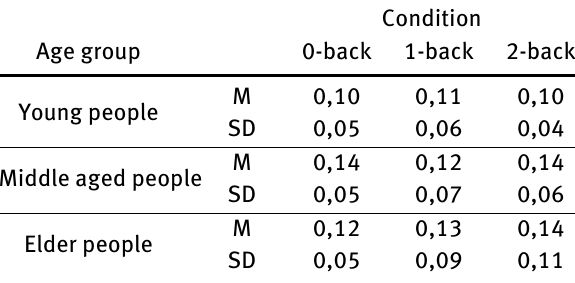
Table 2: The standard deviation of lane position in the 0-back, 1- back, and 2-back conditions in particular age groups, N =